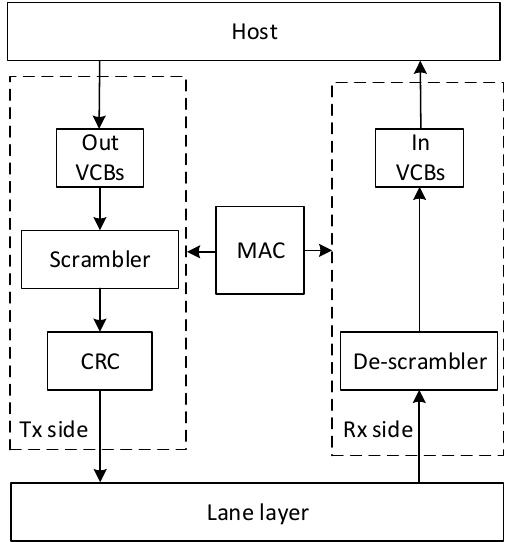
Figure 3. R-SpaceFibre data link layer block